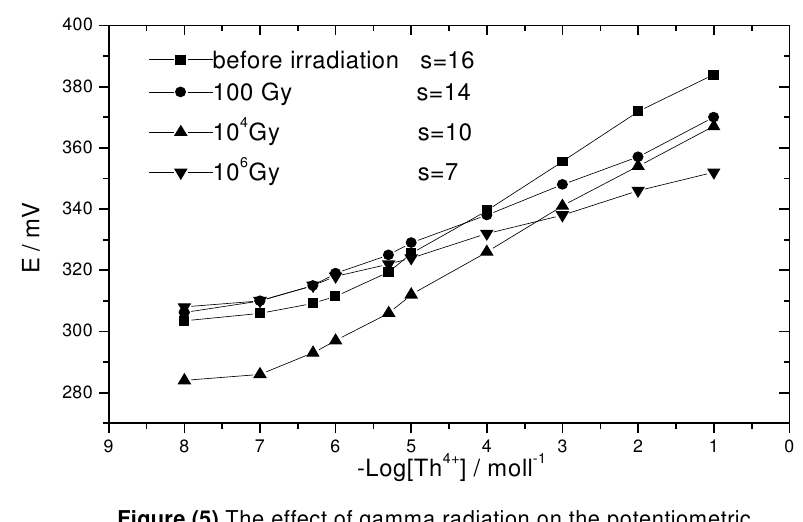
-Log[Th 4+ ] / moll Figure (5) The effect of gamma radiation on the potentiometric calibration response of solid-solid reaction ionophore based electrode